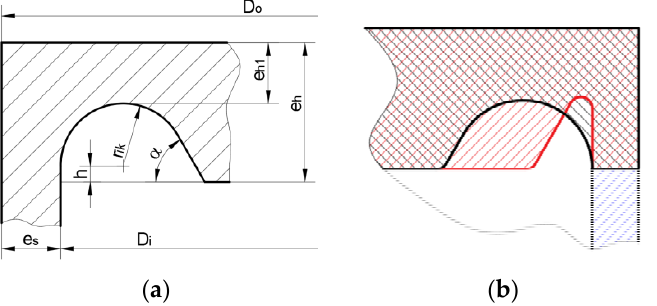
Figure 4. Flat end with stress relief groove: ( a ) geometry and dimensions; ( b ) comparison of tested flat ends with optimal and non-optimal stress relief grooves. Table 1. Measured and nominal dimensions of tested flat ends with stress relief grooves.